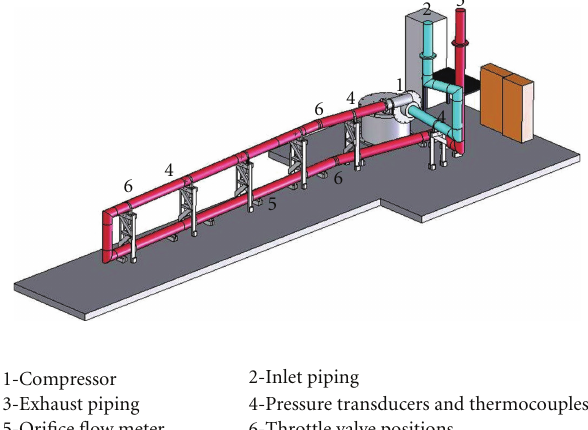
Figure 2: Layout of the experimental setup. Possible throttle valve locations are at 2.2 m, 7.1m, and 15 m along the exhaust piping measured from the compressor.